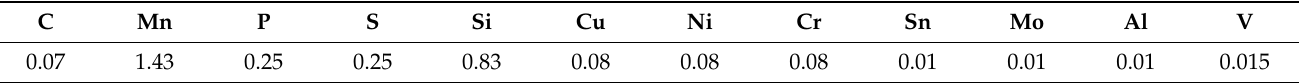
Table 1. Chemical composition of low carbon steel in wt